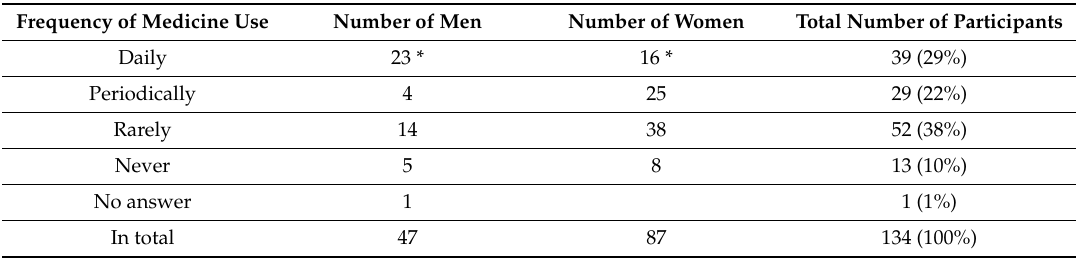
Table 3. Frequency of medicine use among the participants by gender.